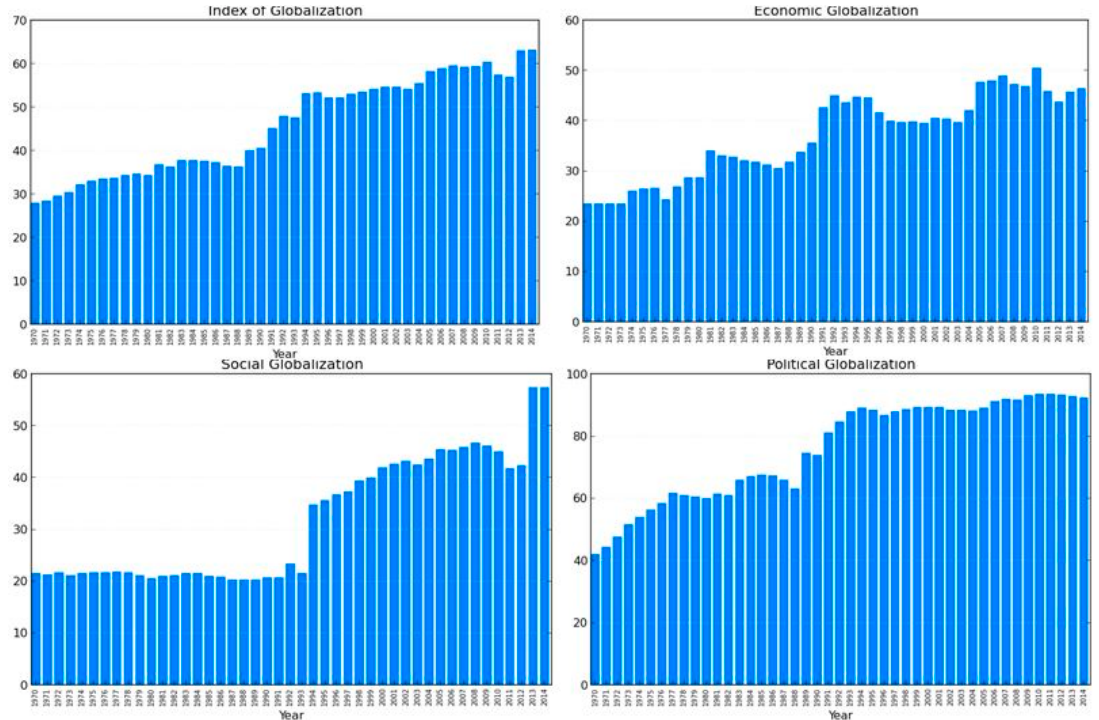
Figure 2. KFO globalization scores for Egypt, 1970–2014.